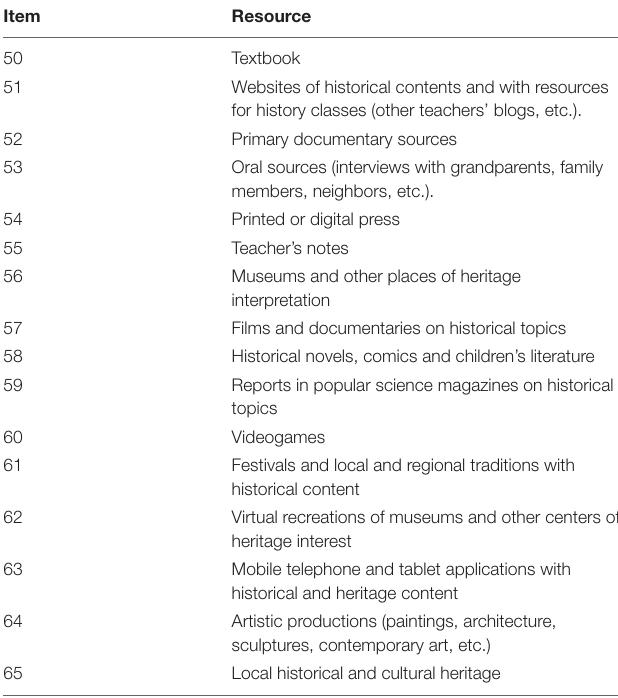
TABLE 2 | Set II.3. In your opinion, which materials and resources are most suitable for the teaching of